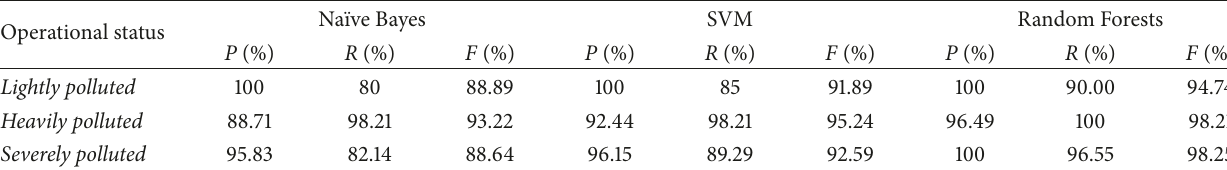
Table 3: Comparison of evaluation metric for different perception